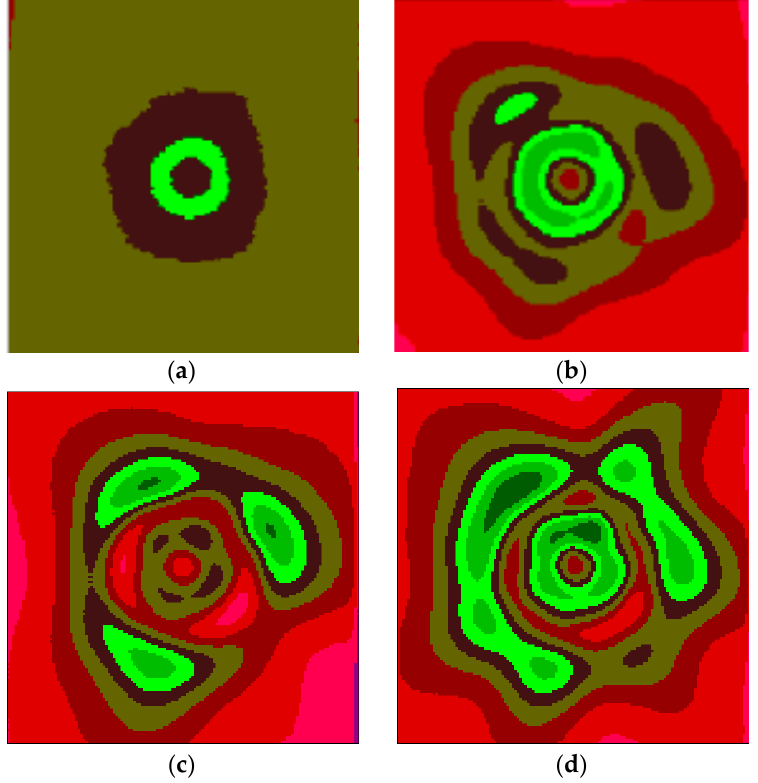
Figure 2. T aw maps for d = 5 mm, z/d = 4 and for increasing Mach number. ( a ) M = 0.3; ( b ) M = 0.67; ( c ) M = 0.85; ( d ) M = 0.91.